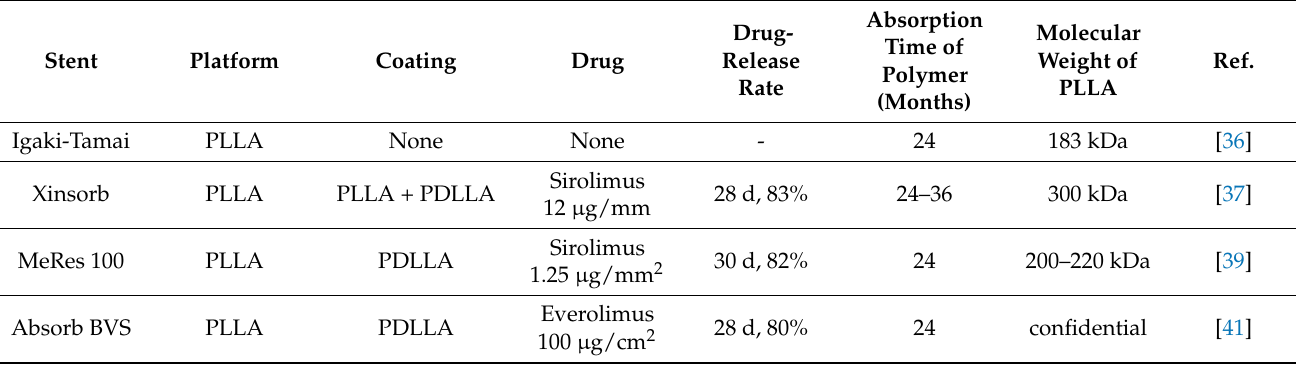
Table 2. Bioresorbable scaffolds (BRSs) with poly-L-lactic acid